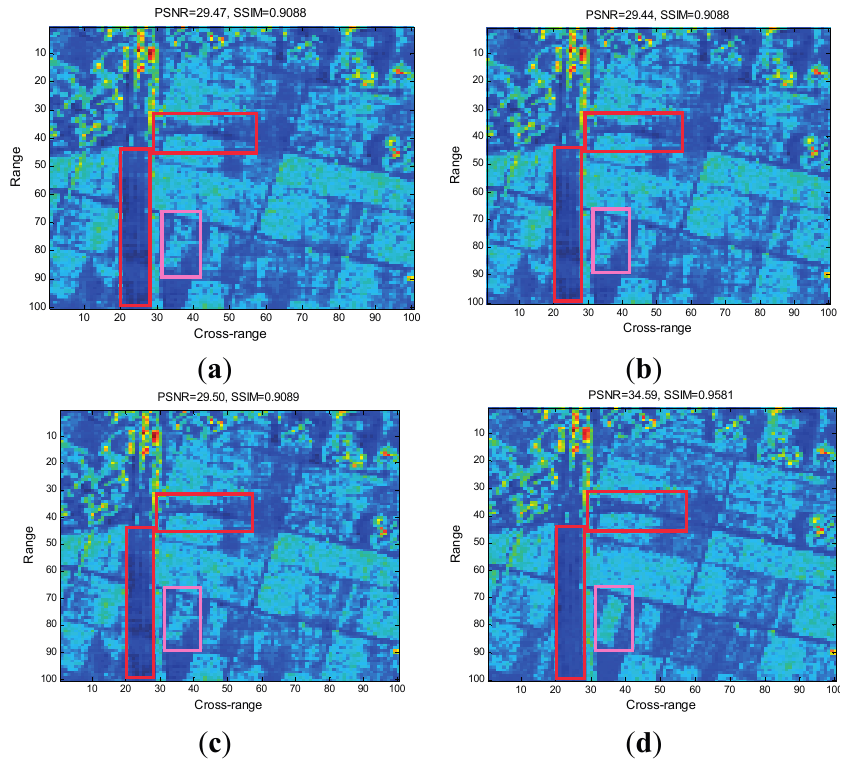
Figure 5. Reconstruction comparison from undersampled SAR echoes. ( a ) Imaging by [9]; ( b ) Imaging by [10]; ( c ) Imagingby [4]; ( d ) Imaging by ASR-CS-SAR.